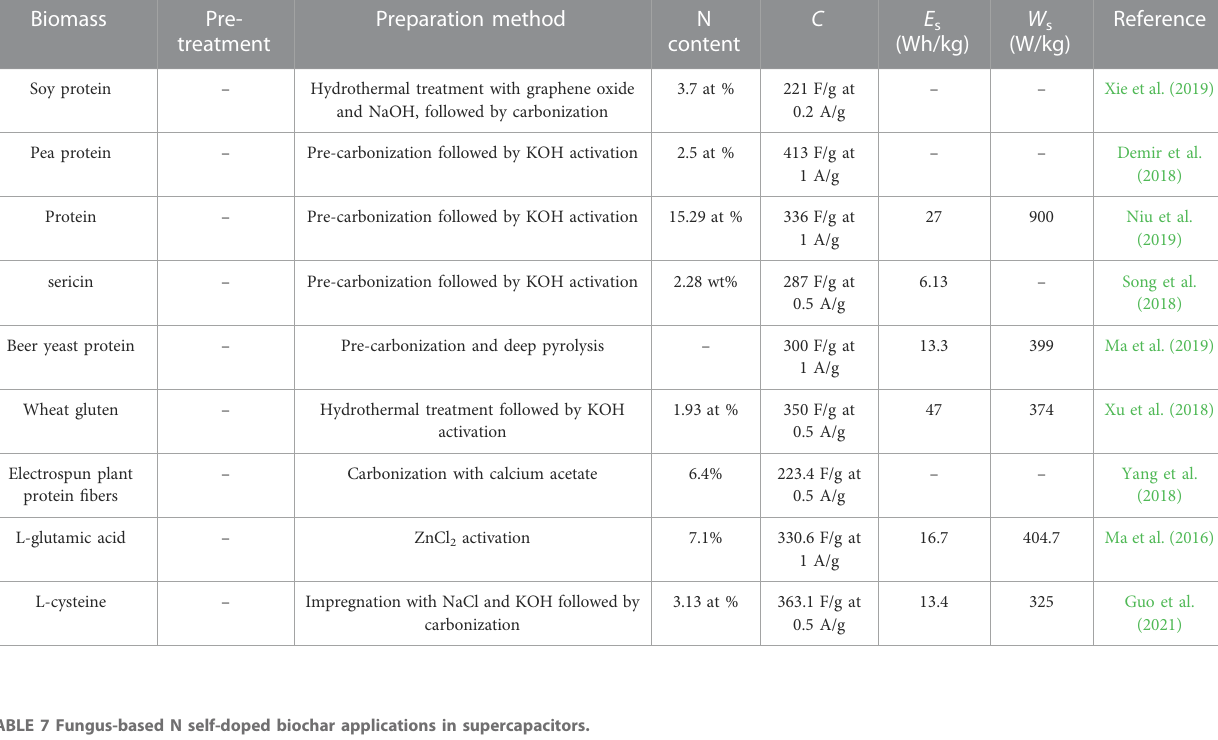
TABLE 7 Fungus-based N self-doped biochar applications in supercapacitors.